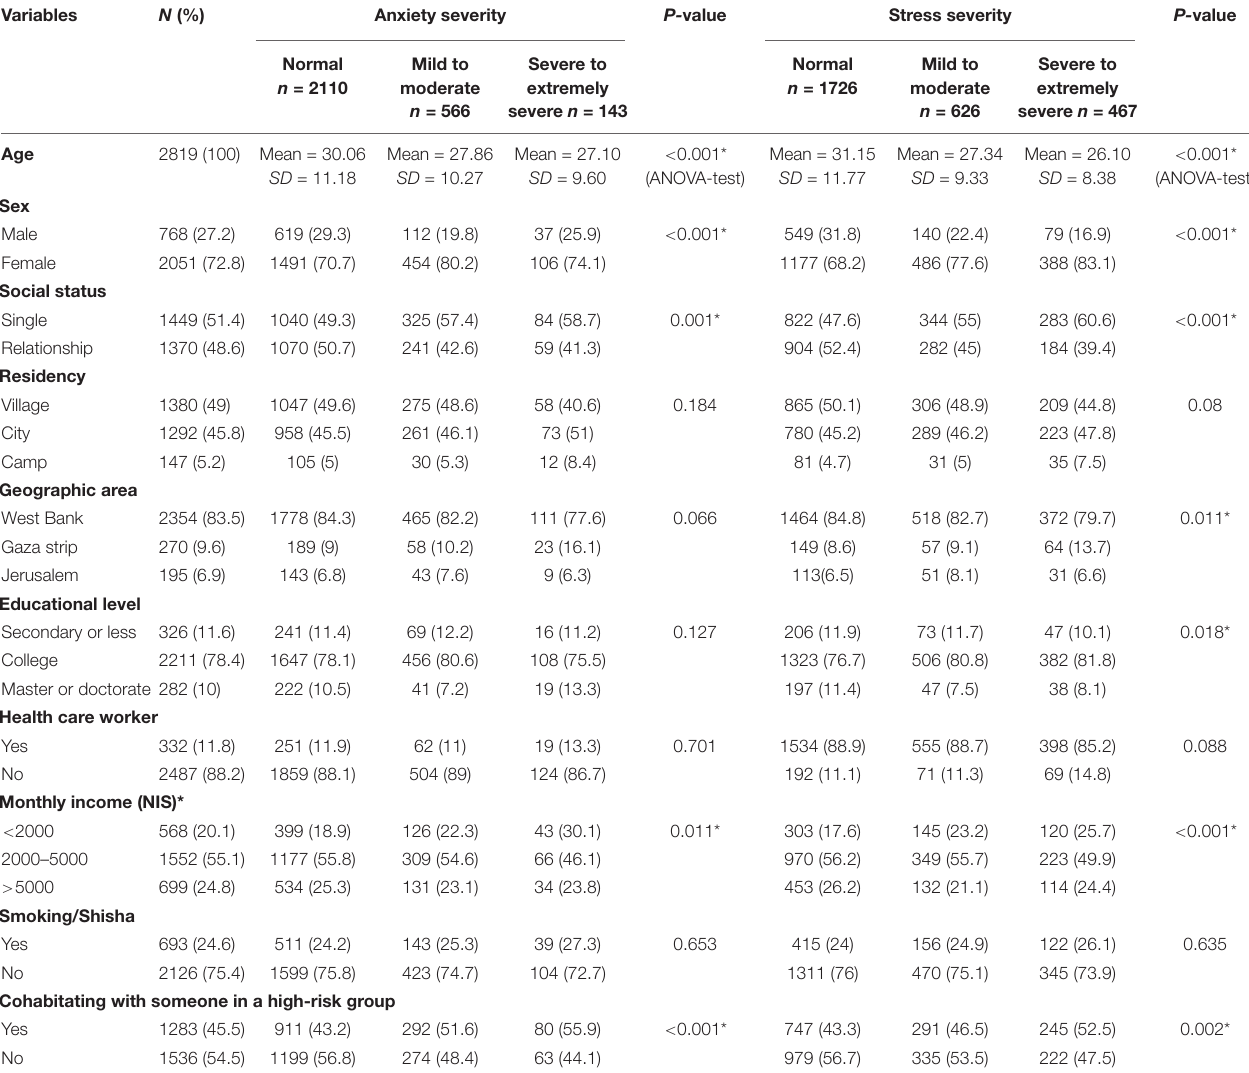
TABLE 1 | Bivariate analysis of socio-demographic characteristics with anxiety and stress severity ( P -value presented was Chi-square significance; N = 2819). Variables N (%) Anxiety severity P- value Stress